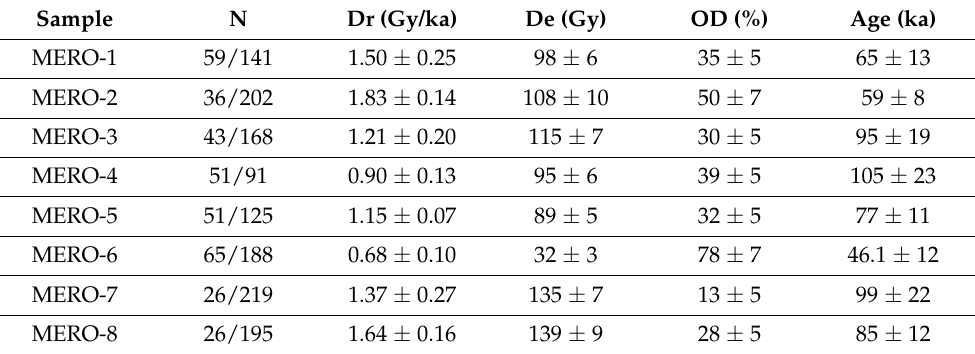
Table 2. Dose rate ( D r ), equivalent dose ( D e ), overdispersion ( OD ) and final ages. N: number of accepted/analysed aliquots. Mero-6 age from central dose (CAM) invalidated by asymmetric